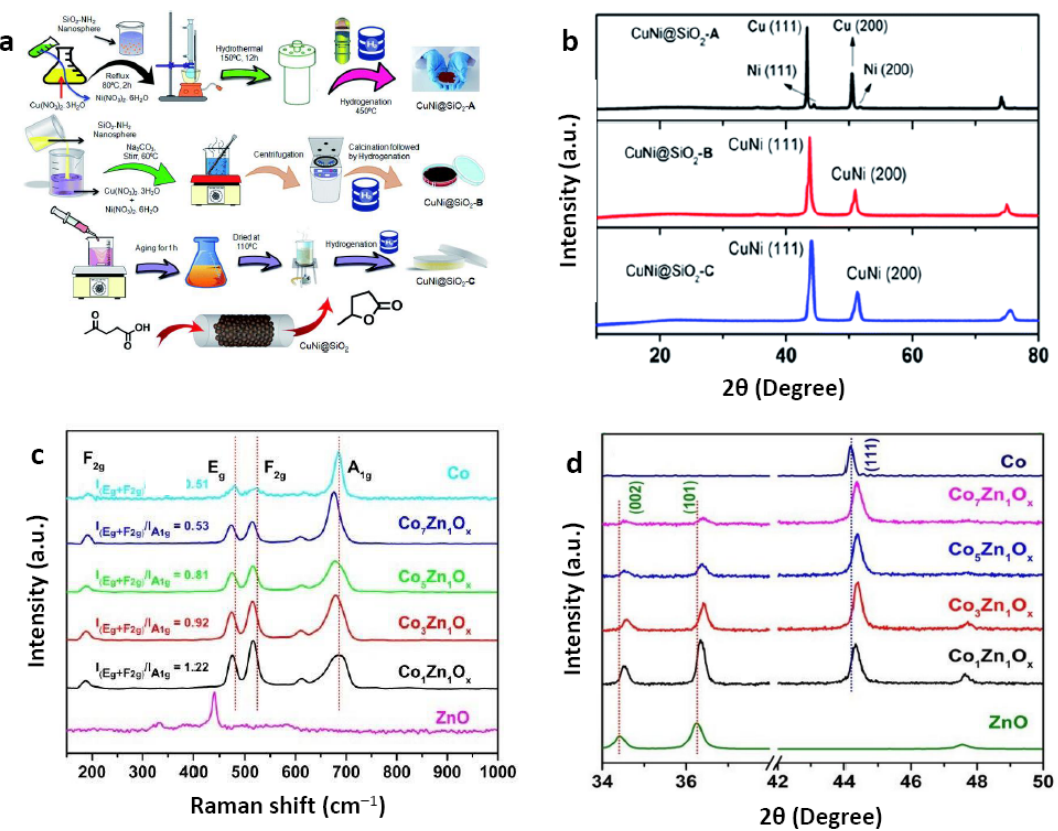
Figure 6. ( a ) Schematic illustration of the synthesis of Cu − Ni bimetallic nanoalloy catalysts using three different methods and their catalytic applications for LA hydrogenation to GVL. ( b ) Powder XRD spectra. Reproduced with permission from Reference [59]. Copyright 2014, Royal Society of Chemistry. ( c ) Raman spectra of catalysts. ( d ) XRD patterns of catalysts. Reproduced with permission from Reference [60]. Copyright 2020, Royal Society of Chemistry.